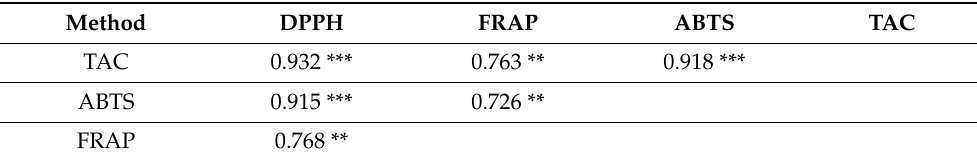
Table 2. Correlation matrix (Pearson’s correlation coefficients) for the study of grapefruit extract and Al 2 O 3 NPs.